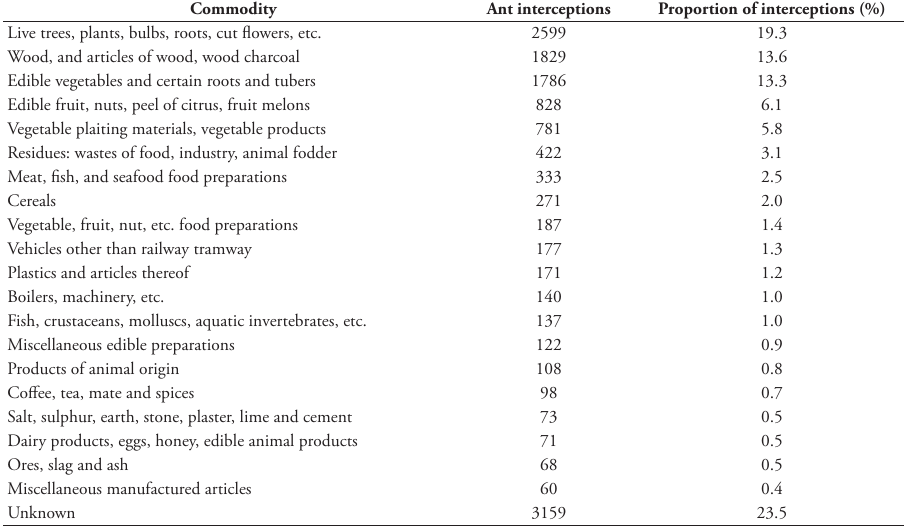
Table 2. The top 20 commodity groups for ant interceptions in Australia from 1986 to 2010. Commodity Ant interceptions Proportion of interceptions (%) Live trees, plants, bulbs, roots, cut flowers,